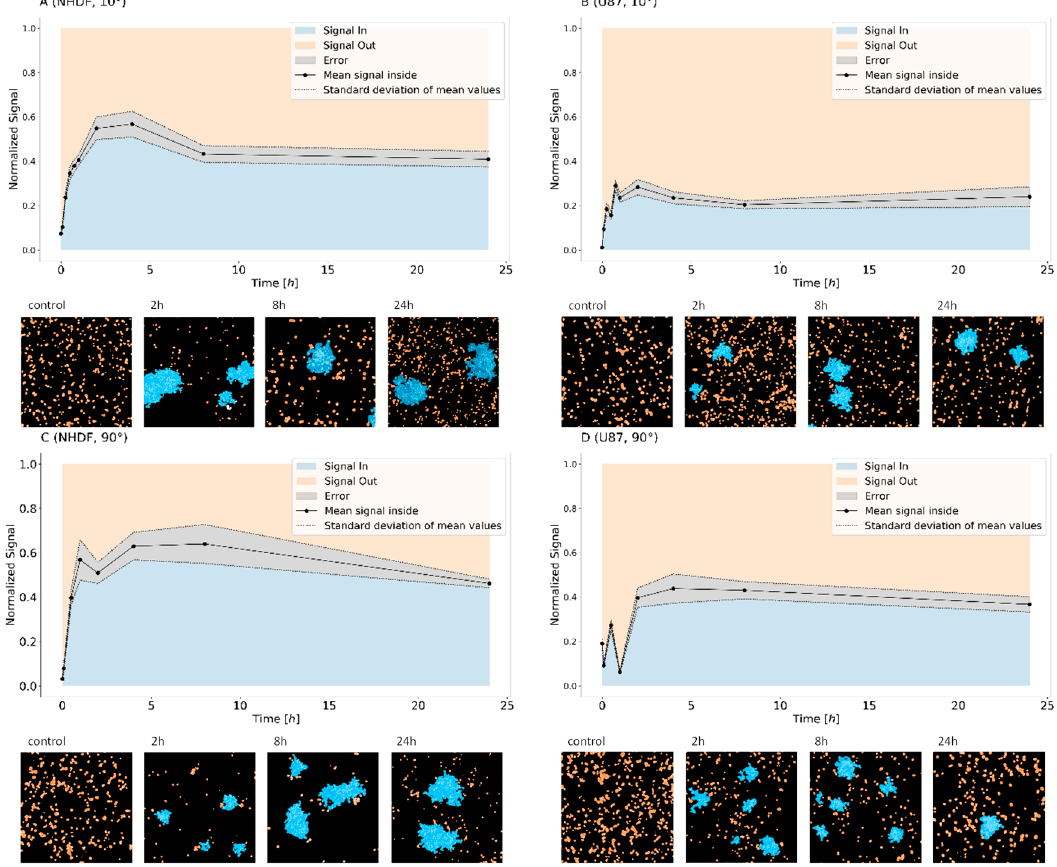
Figure 3. Relative amounts of 53BP1 signals detected within (blue) and outside (orange) repair clusters as defined for SMLM (see Section 4.6). Graphs: Mean values and margins given by the standard deviation are depicted in gray. The values are always normalized to the mean number of signals detected at a given time point. The data are presented for NHDF fibroblasts ( A , C ) and U87 cells ( B , D ) after 1.3 Gy tangential 15 N-irradiation ( A , B ) (10° angle between the ion beam and the cell layer), and 4 Gy perpendicular 15 N-irradiation ( C , D ) (90° angle between the ion beam and the cell layer). Images: The pointillist images represent examples of sections of cell nuclei with labeling points inside (blue) and outside (orange) clusters at the given time points. The samples were taken as aliquots of the same culture at different time points (from 5 min to 24 h) after irradiation. For comparison, examples of non-irradiated control cells are presented (=0 min).